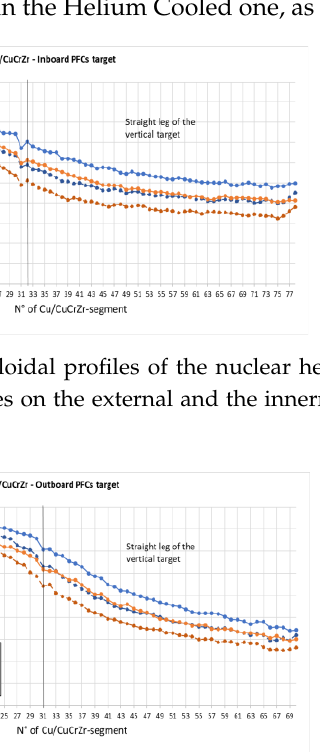
paring the values on the external and innermost target sides, both for WCLL and HCPB blanket case.